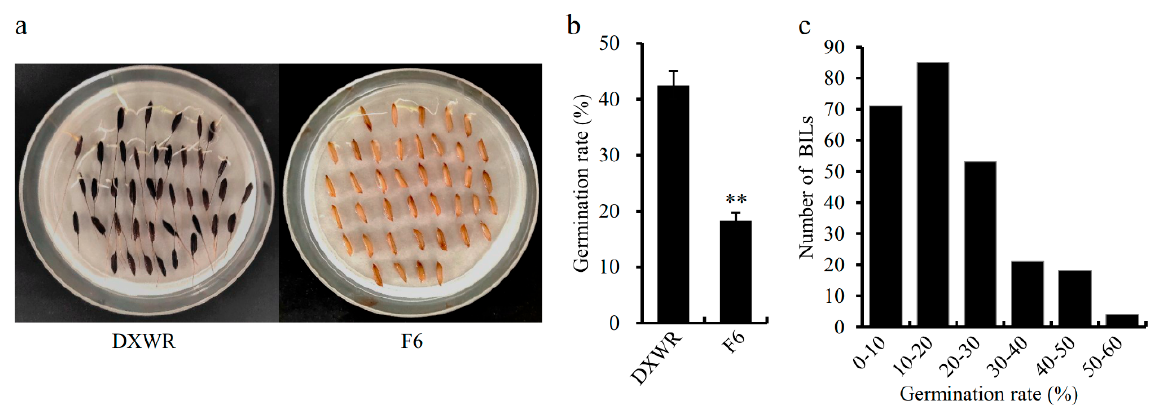
Figure 1. Germination rates of Dongxiang wild rice (DXWR), F6 and their backcross inbred lines (BILs) after aging treatment. ( a ) the germination rate of DXWR was significantly higher than that of F6 after aging treatment. ( b ) average germination rates of DXWR and F6 after aging treatment. Significant differences are indicated by asterisks (Student’s t -test; p -value < 0.01). ( c ) distribution of germination rates in BILs population from crosses DXWR and F6 after aging treatment.